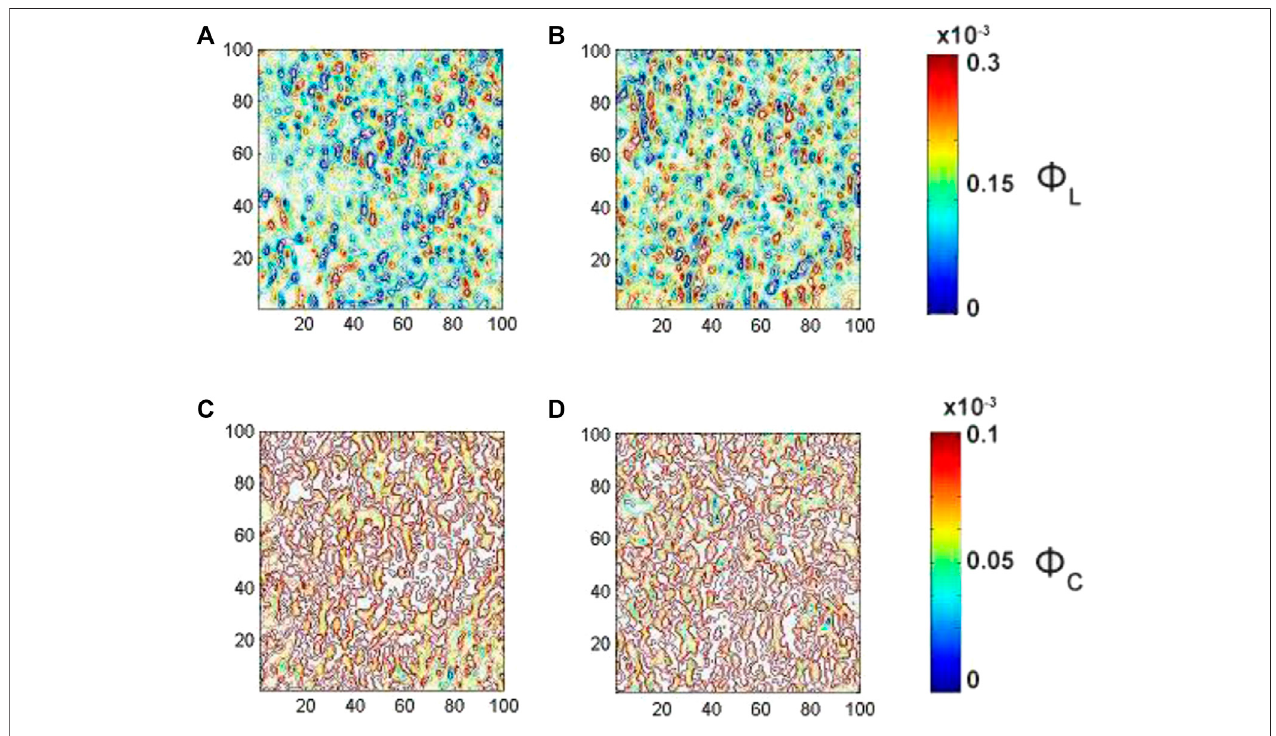
FIGURE 5 | Embossed topographic maps of linear (A) Φ L ( θ 3 (cid:1) 1 . 5 rad 5 z p 3 ≈ 100 μ m ) and (B) Φ L ( θ 4 (cid:1) 2 . 3 rad 5 z p 4 ≈ 150 μ m ) and circular (C)